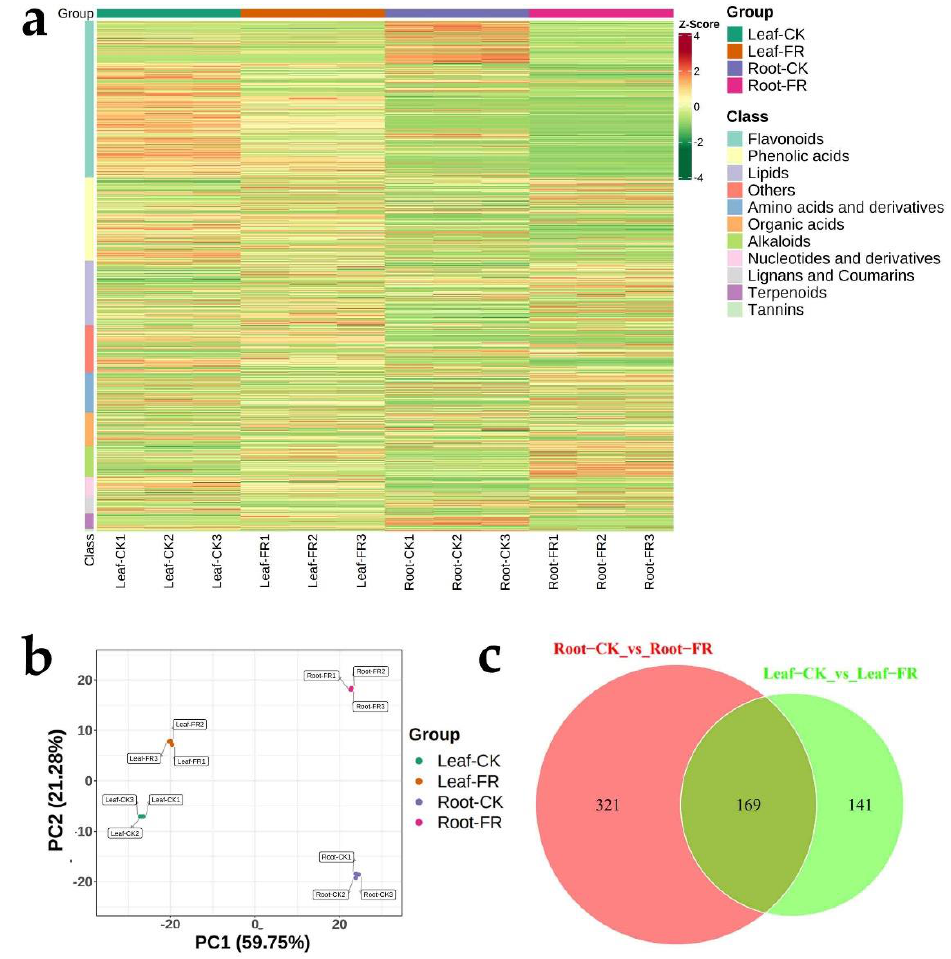
Figure 5. Metabolite composition of LC leaves and roots in the FR and CK zones of LM fairy rings. ( a ) Clustering heat map of all metabolites. Each column represents a sample, and each row represents a metabolite class. A bar with a specific color represents the abundance of each metabolite. Different shades of red and green represent the upregulated and downregulated metabolites, respectively. ( b ) PCA score plot. PC1 represents the first principal component, and PC2 represents the second principal component. The percentage represents the interpretation rate of the principal component of the dataset. A dot represents each sample, and samples indicated in the same color are of the same group. ( c ) The Venn diagram shows the overlapping and unique metabolites among the comparison groups. In the figure, each circle represents a comparison group, and the numbers in the circles and overlaps represent the number of differential metabolites shared between the comparison groups, while the numbers without overlaps represent the number of differential metabolites unique to the comparison group.